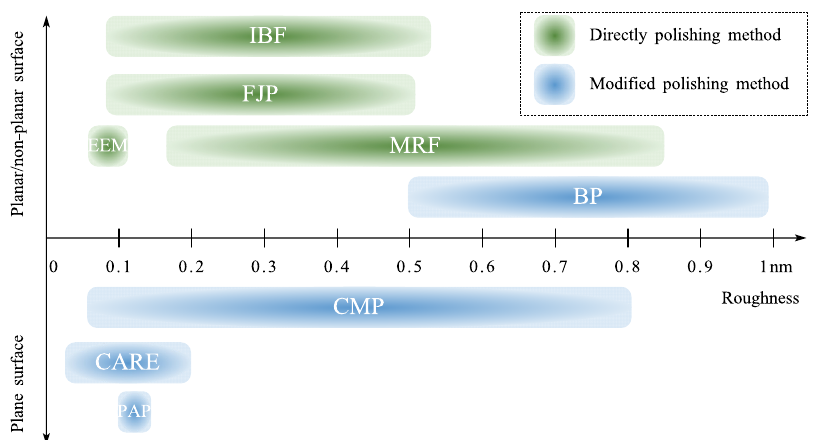
Figure 36. The roughness range of different machining approaches.